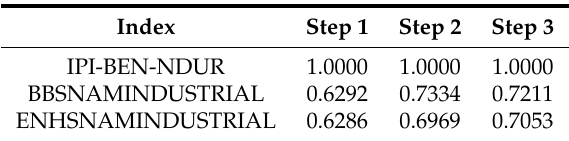
Table 17. Comparison of the ratios of RMSE for models for capital goods with an expanding window from 2008:01 to